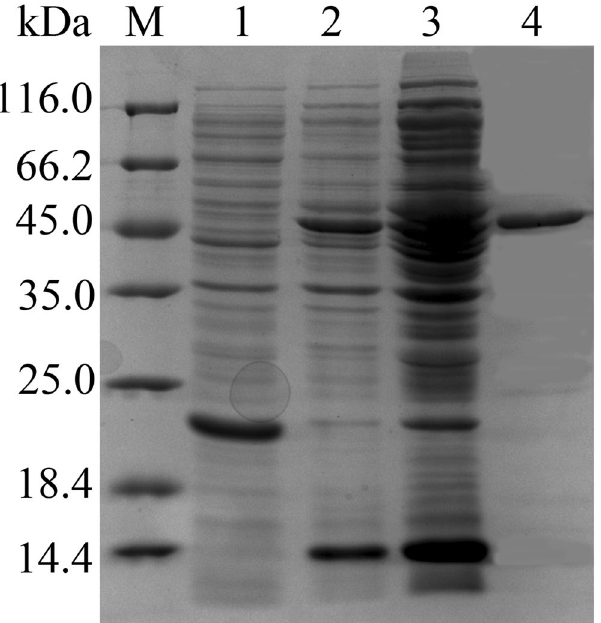
Figure 1. SDS-PAGE analysis of the purified AiiK. M: molecular weight marker; Lane 1: pET32a vector plasmid (control); Lane 2: supernatant of the sonication product; Lane 3: precipitate of the sonication product; Lane 4: AiiK purified via